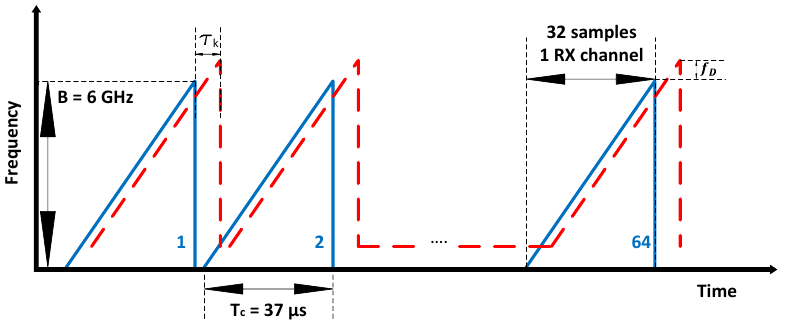
Figure 4. FMCW waveform in the frequency